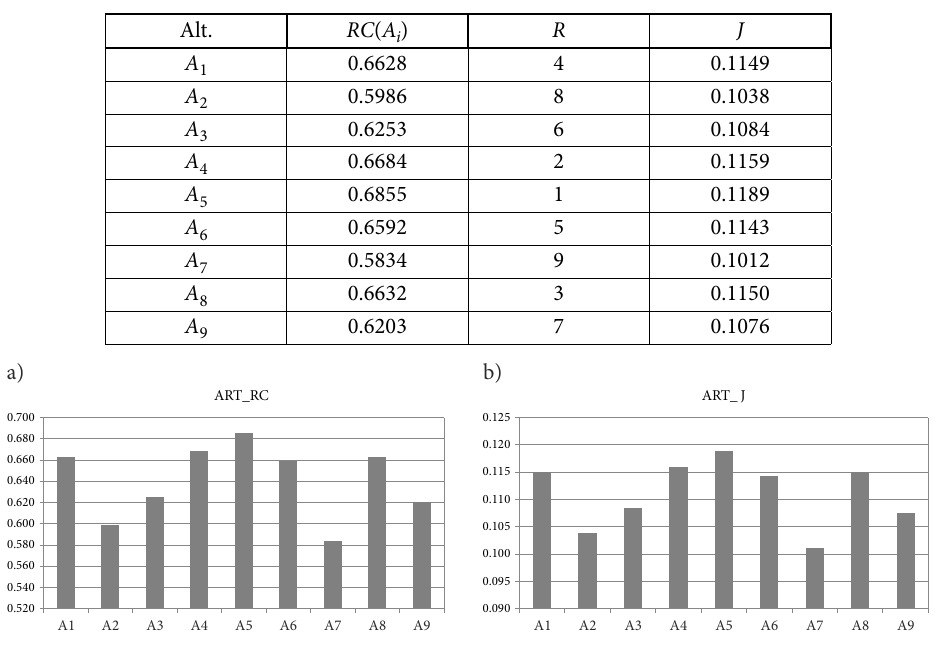
Figure 5. Rankings of gerontechnologies after using the aggregation operator (18) with objective criteria weights based on a) RC ( A i ) , b) J Table 8. Objective criteria weights after using the aggregation operator (19) w